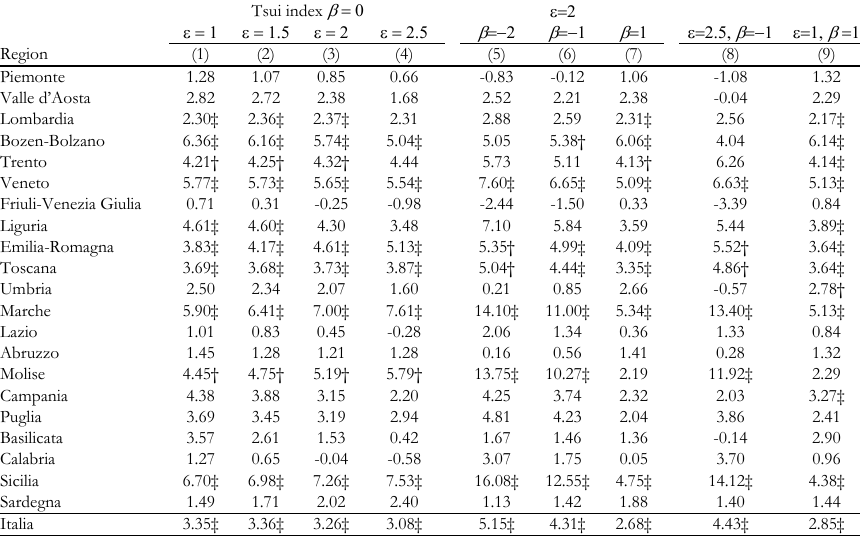
Regional multidimensional well-being measures: percentage changes